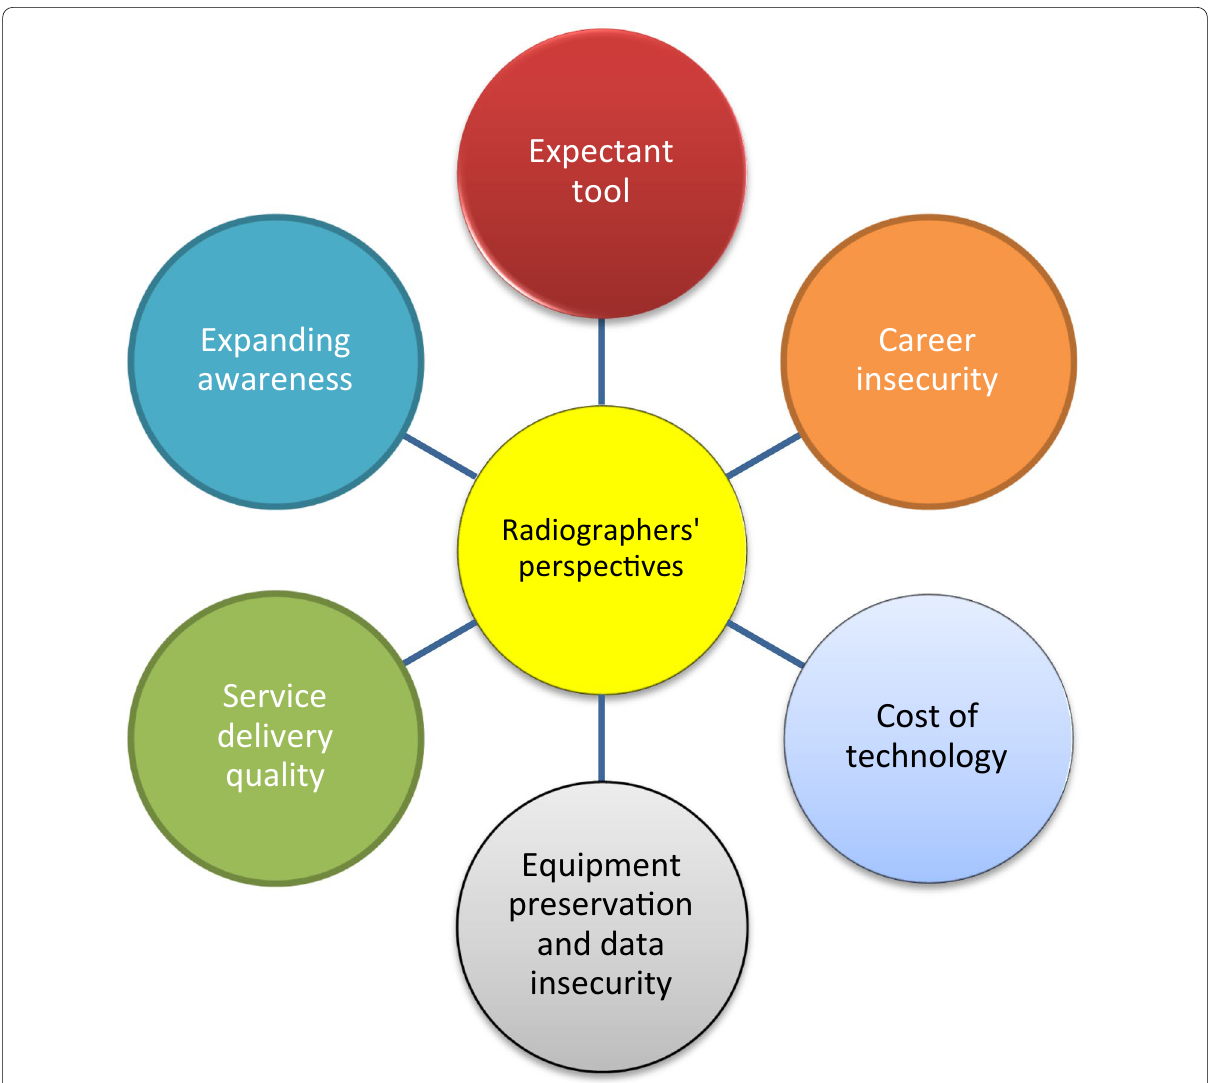
Fig. 1 Summary of radiographers’ perspectives on AI technology implementation and